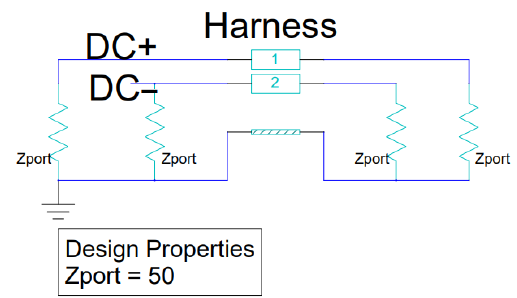
Figure 8. The impedance diagram of the harness model.